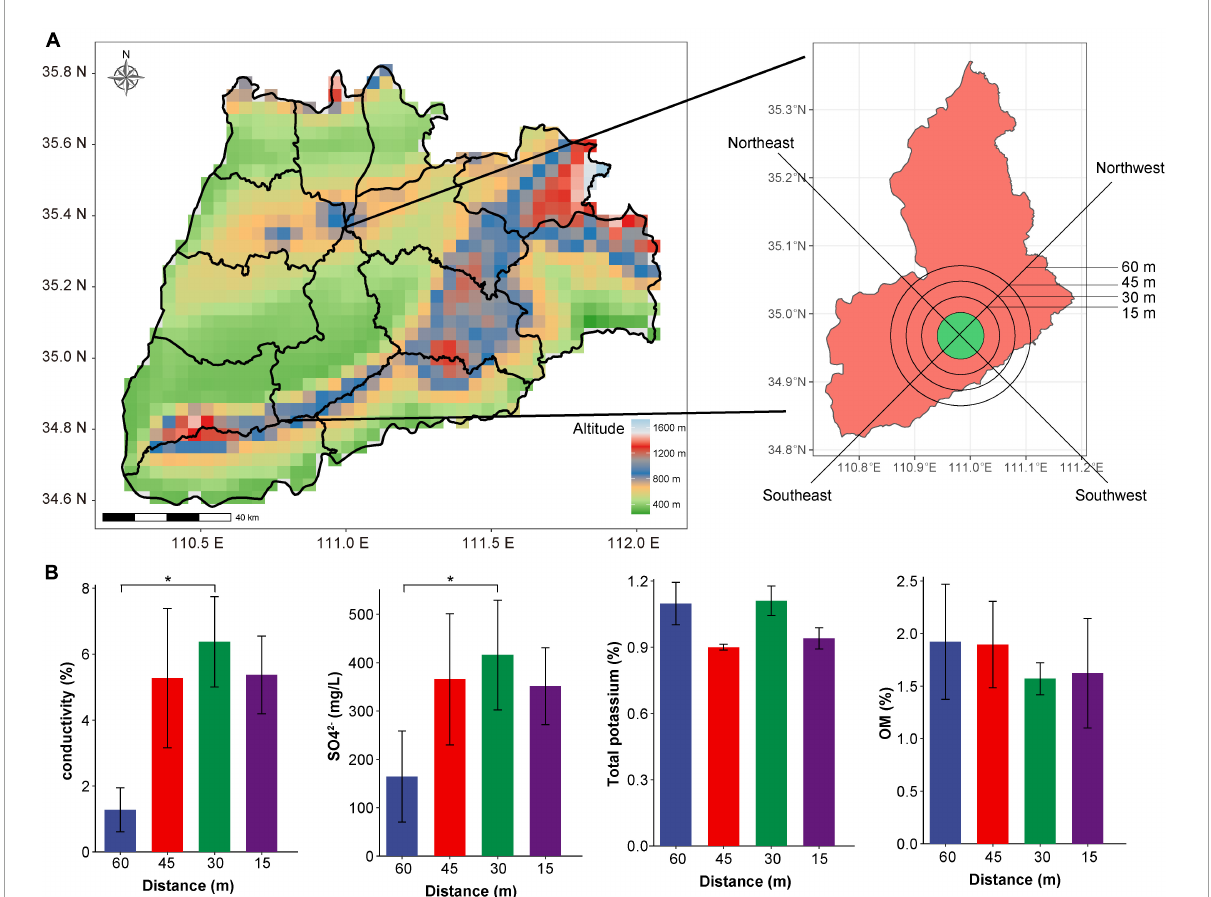
FIGURE1 Satellite cloud image and physical and chemical indices of soil sampling points in Yuncheng Salt Lake. (A) Satellite cloud image of Yuncheng Salt Lake, Shanxi Province, China; (B) represents the changes in electrical conductivity, SO4 2 − , total potassium and OM content in soil at different distances (15, 30, 45, 60 m) from the lake shore. Data were analyzed by one-way ANOVA (* p <